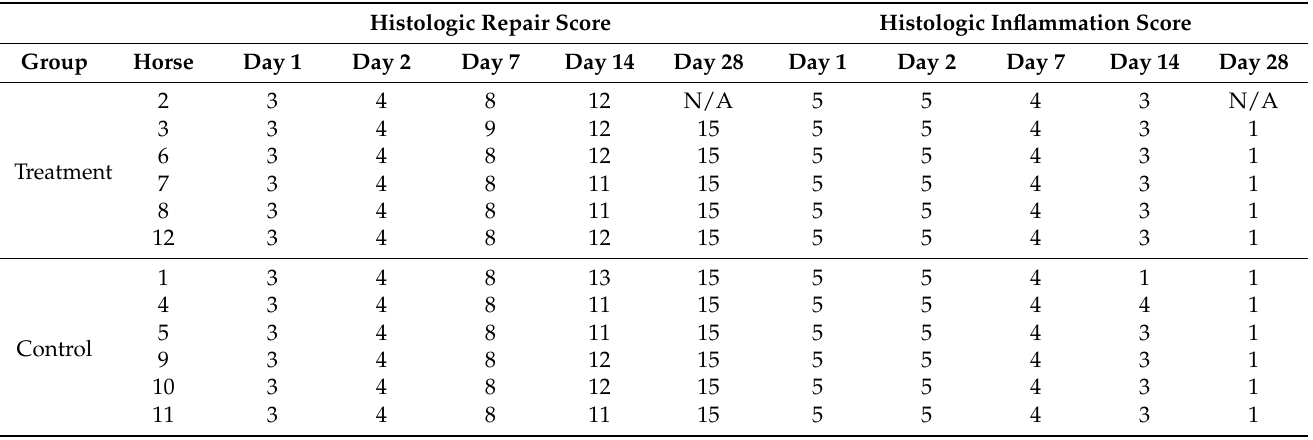
Table 4. Individual histologic repair and inflammatory scores of limb wounds following IV allo-CB-MSC administration in horses. Histologic Repair